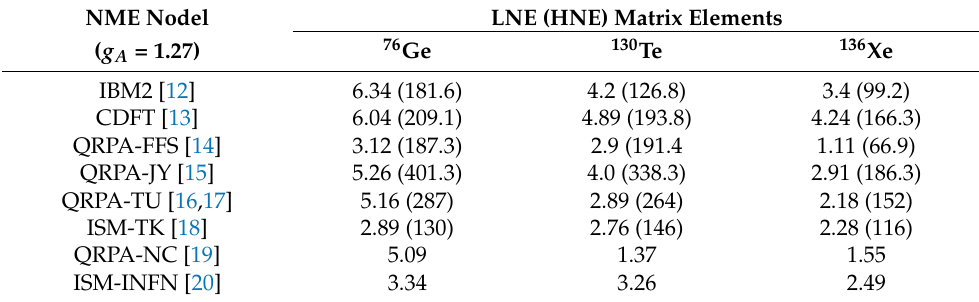
Table 1. The NME for the LNE (HNE) and the three isotopes 76 Ge, 130 Te, 136 Xe, computed by different nuclear models on the assumption g A = 1.27. NME Nodel LNE (HNE) Matrix